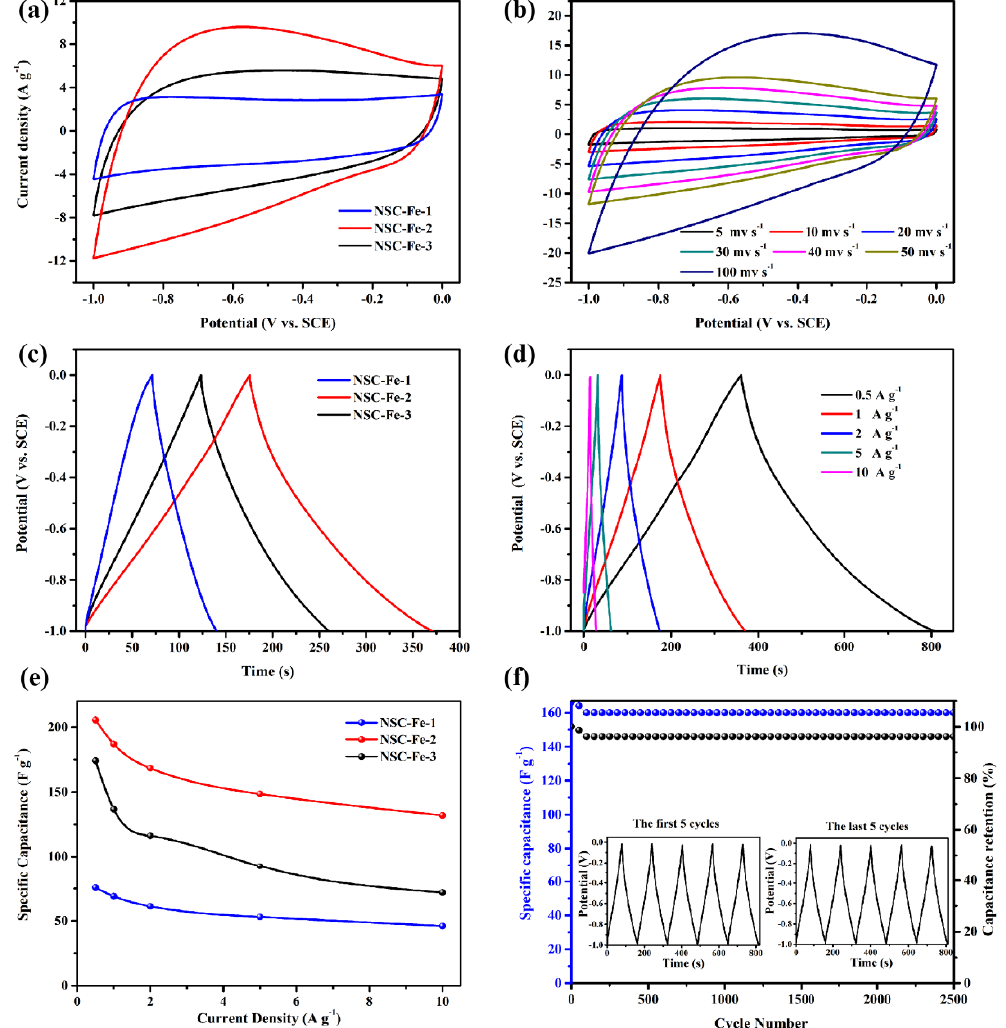
Figure 6. Tests performed in a three-electrode device (6 M KOH): ( a ) CV curves of NSC-Fe- x at a 50 mV s −1 scan rate, ( b ) CV curves of the NSC-Fe-2 electrode at different scan rates, ( c ) galvanostatic charge/discharge (GCD) curves at 1 A g −1 of NSC-Fe- x , ( d ) GCD curves at various current densities of NSC-Fe-2, ( e ) specific capacitance of NSC-Fe- x at various current densities, and ( f ) cycle life of NSC-Fe-2 at 2 A g −1 .